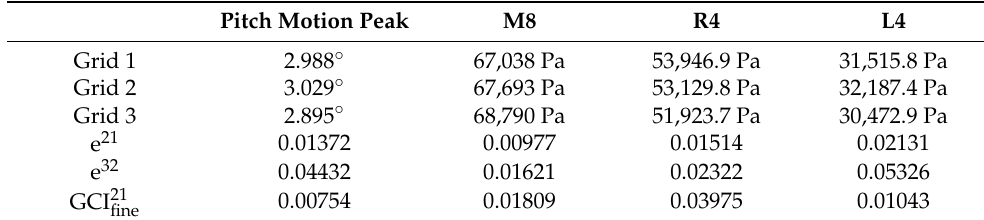
Table 4. Grid uncertainty analysis summary.